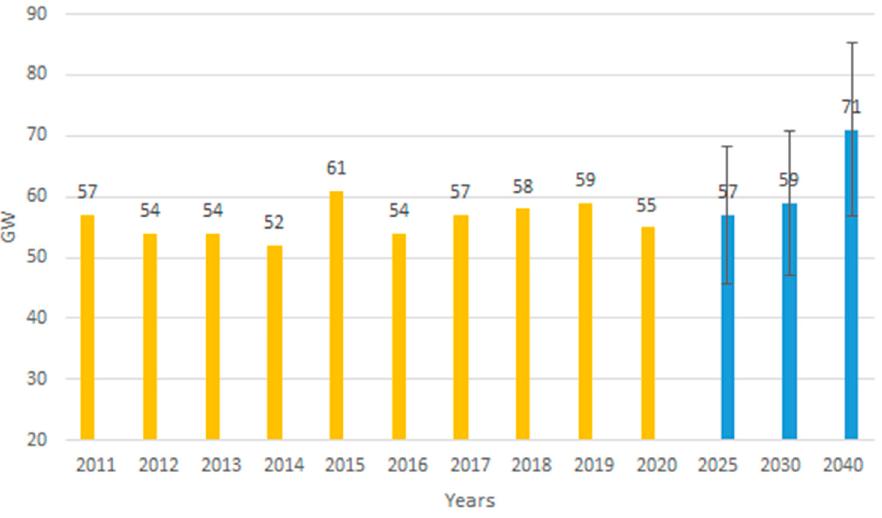
Figure 7. Evolution and forecast of the Italian peak yearly demand in GW.